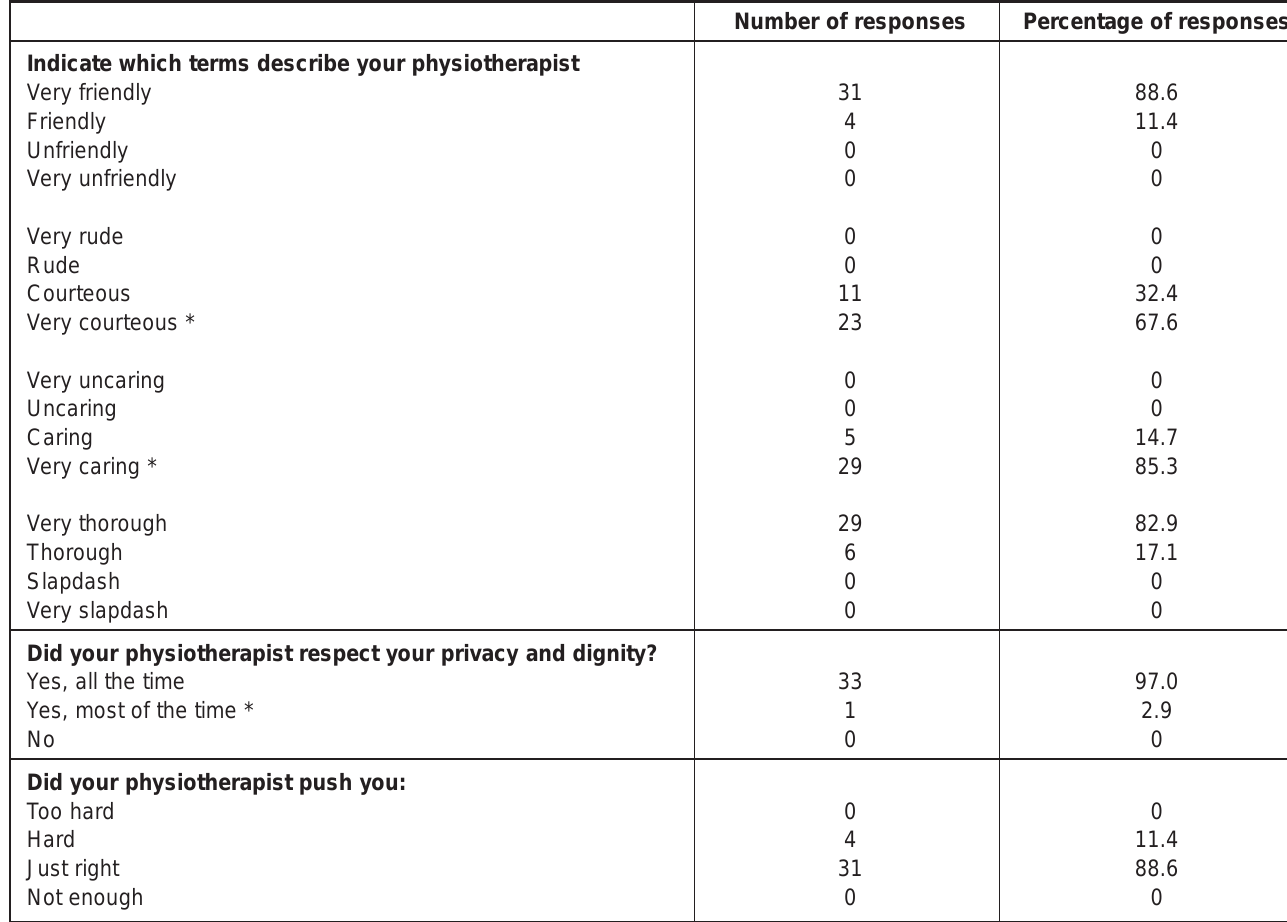
Table 1: Patients’ responses when asked to indicate terms which described their physiotherapist.